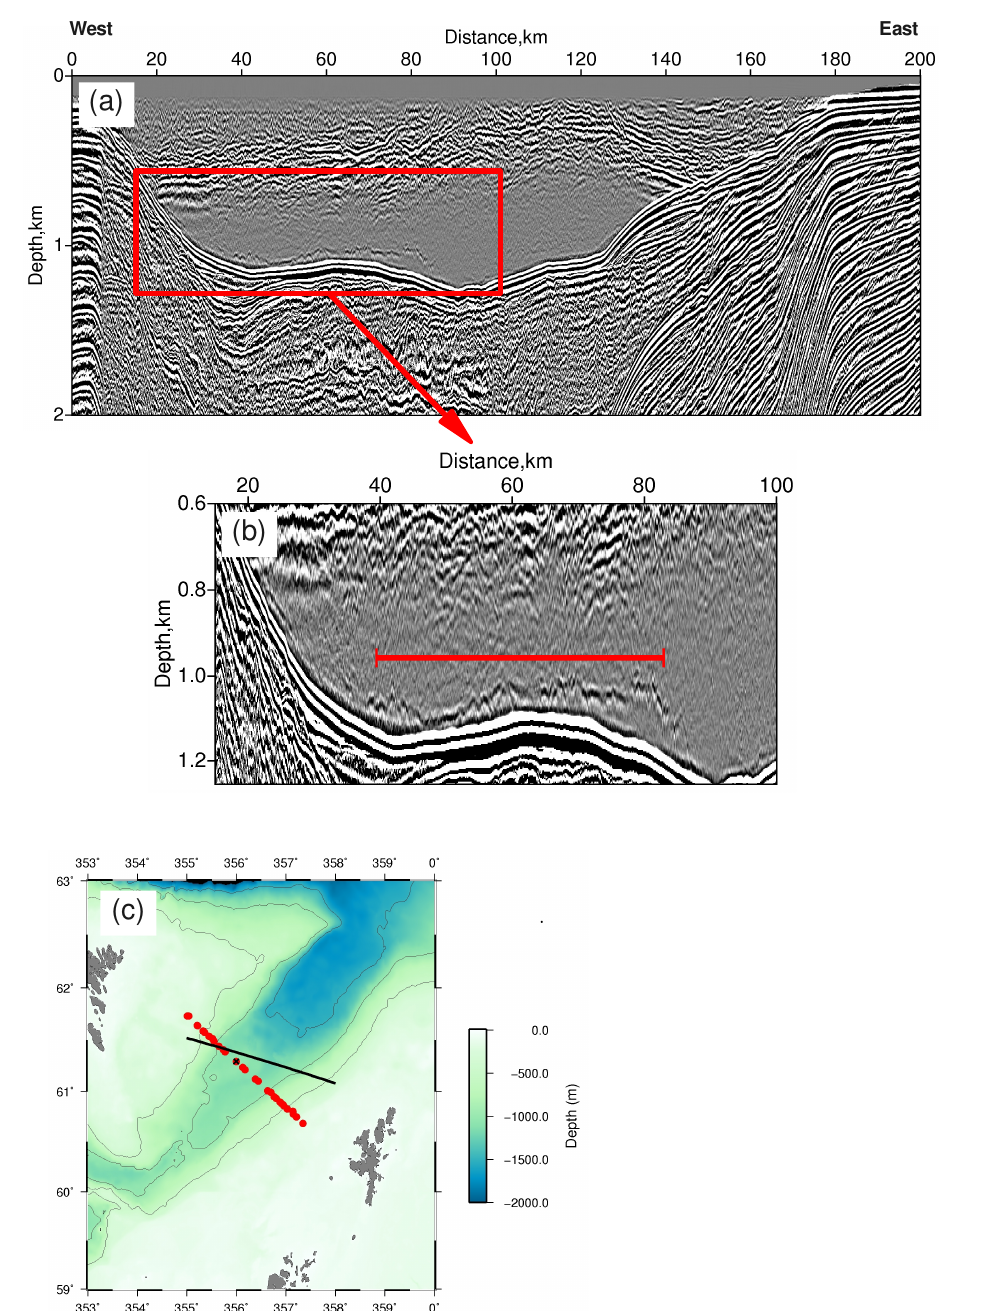
Fig. 1. (a) a depth converted stacked seismic section of the FAST profile (England et al., 2005) reprocessed to recover the reflectivity in the water layer. The seabed reflection is the high amplitude event that can be traced from the centre of the trough at about 1.2km depth onto the margins. The band of reflectivity at a depth of about 500m is caused by mixing of the North Atlantic Water with the Faroe-Shetland Channel Bottom Water. (b) the inset in rectangle focuses on the near-bed reflections between 65 and 82km of the profile which we investigate in this paper. The red line shows the section of data used to compute the histograms in Fig. 4. (c) a map showing the location of profiles used in this study: black line: the FAST seismic profile; red dots: locations of CTD and moorings (Bonnin et al., 2002; Hosegood et al., 2005) cross signifies location used for modelling sound-speed and density profiles (see Fig.